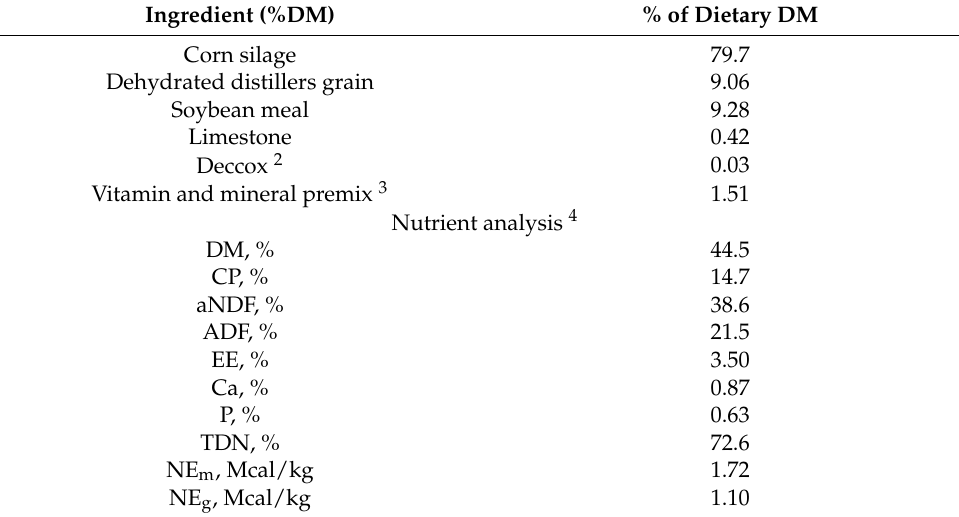
Table 1. Ingredient and chemical composition of the basal diet 1